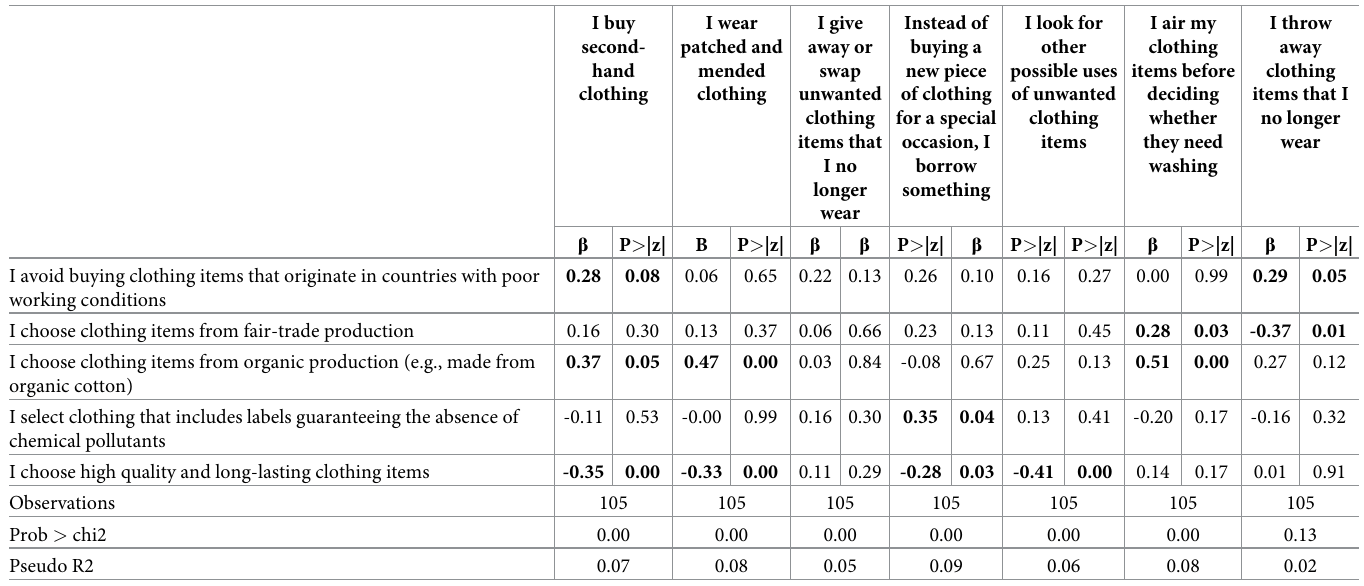
Table 4. Logistic regression of